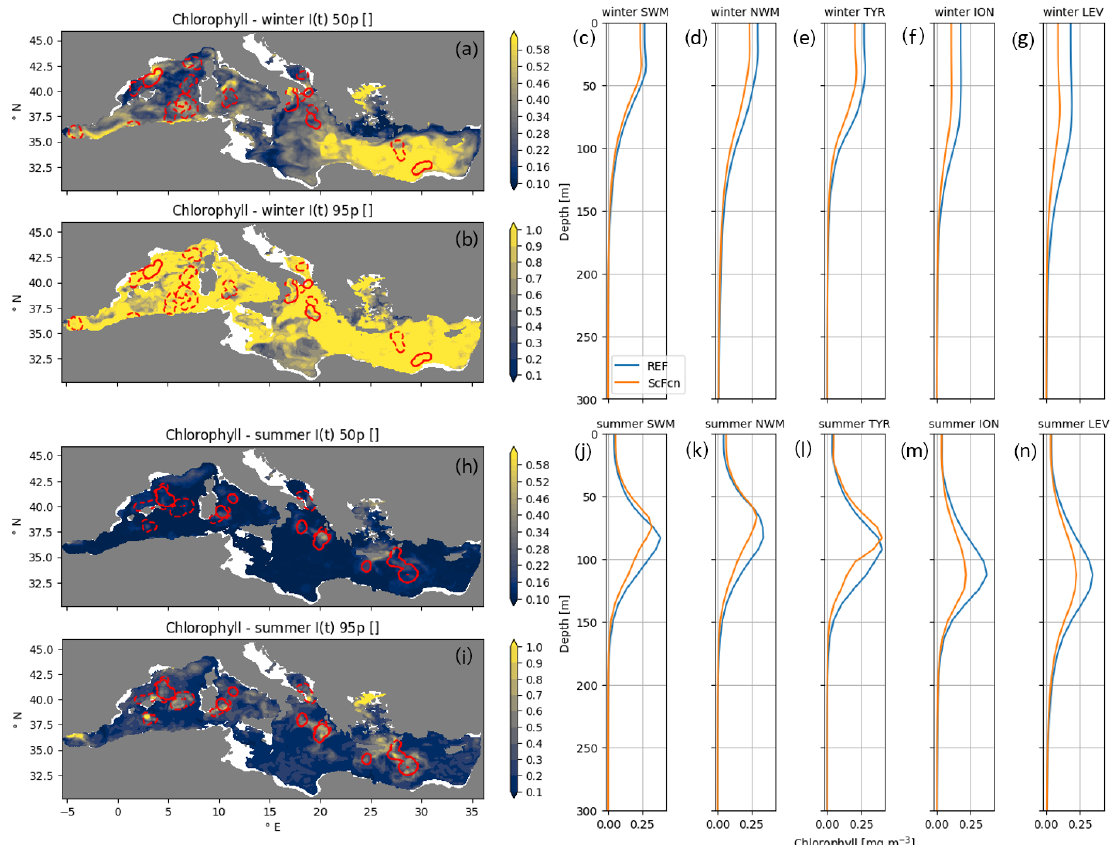
Figure 7. Maps of the I xy (t) 50th and 95th percentiles for nitrate in winter and summer (a, b, h , and i) ; red contours identify the areas within three correlation radii from the float position (dashed lines for floats without nitrate observations). Mean profiles at time and location with I xy (t) higher than 0.3 in five sub-basins for the ScFcn and REF simulations (c, d, e, f, g, j, k, l, m , and n) in winter (c–g) and summer (j–n)